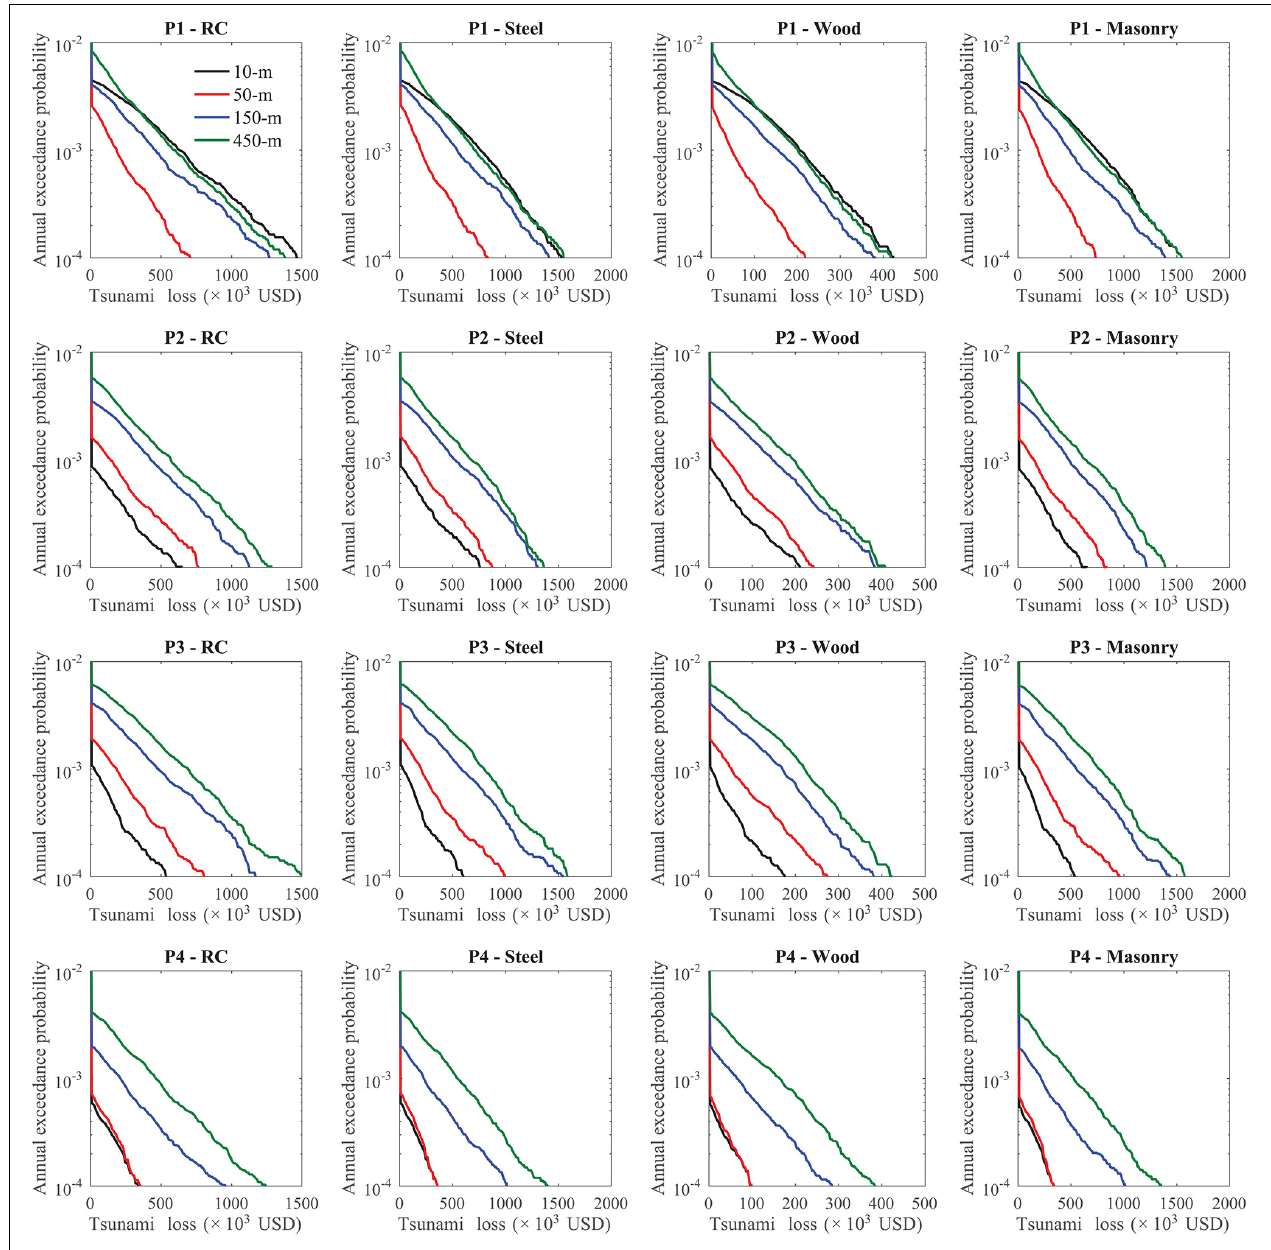
FIGURE 8 | Tsunami loss EP curves at different locations in